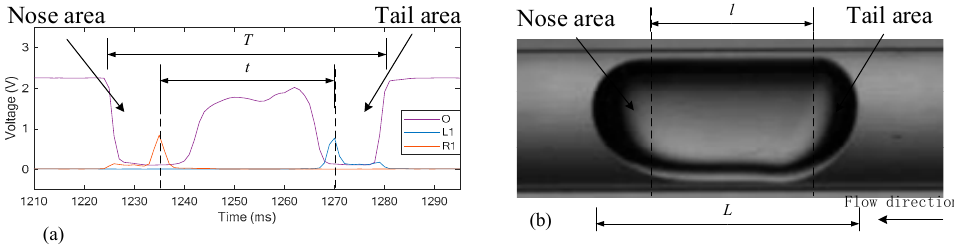
Figure 5. ( a ) Optical signals of the horizontal array; ( b ) flipped image of a single slug.